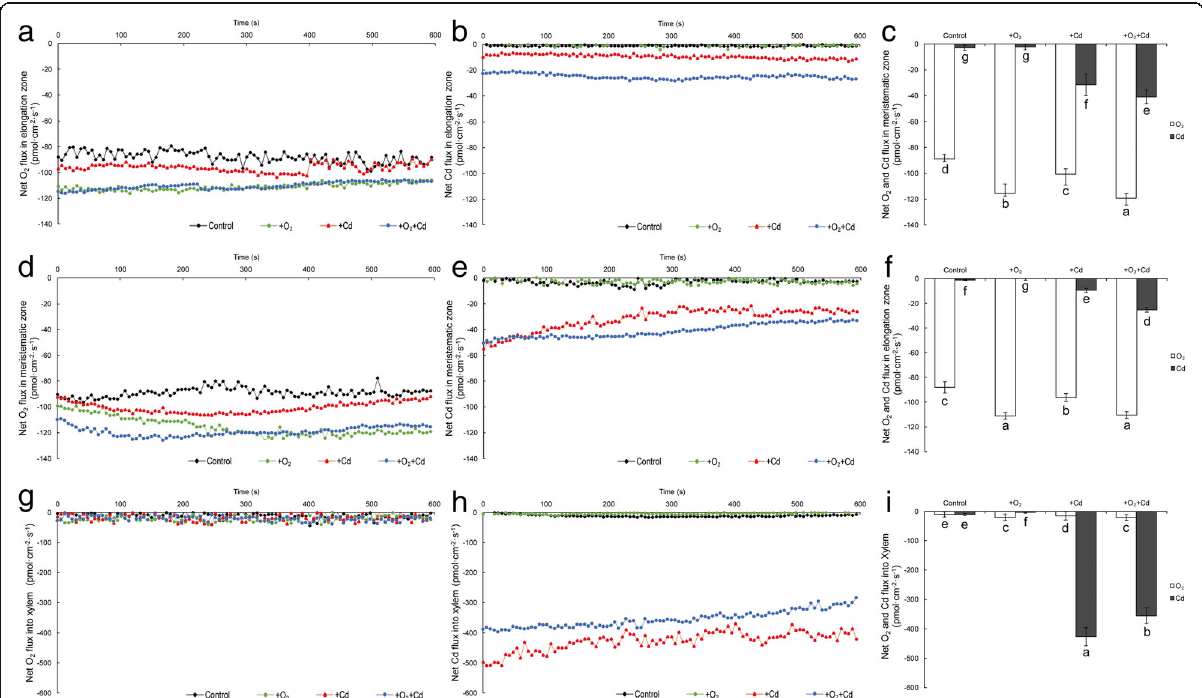
Fig. 3 Effects of aeration or/and 50 μ M CdCl 2 treatments on net O 2 and Cd 2+ fluxes in the roots of rice seedling. a Time-course of Net O 2 flux on the surface of root at 500 μ m from root apex (elongation zone); b Time-course of Net Cd 2+ flux on the surface of root at 500 μ m from apex (elongation zone); c Statistical results of steady-state net O 2 and Cd 2+ fluxes on the surface of root at 500 μ m from apex (elongation zone); d Time-course of Net O 2 flux on the surface of root at 200 μ m from root apex (meristematic zone); e Time-course of Net Cd 2+ flux on the surface of root at 200 μ m from apex (meristematic zone); f Statistical results of steady-state net O 2 and Cd 2+ fluxes on the surface of root at 200 μ m from apex (meristematic zone); g Time-course of Net O 2 flux in the xylem of root at 500 μ m from root apex (elongation zone); h Time-course of Net Cd 2+ flux in the xylem of root at 500 μ m from apex (elongation zone); i Statistical results of steady-state net O 2 and Cd 2+ fluxes in the xylem of root at 500 μ m from apex (elongation zone). The 3-week-old rice seedlings under hydroponic culture were aerated with air pump (30min per hour) in the absence or presence of 50 μ M CdCl 2 for 14 d. The values are means ± SE ( n =100). Different letters on bar indicate significant differences at P <